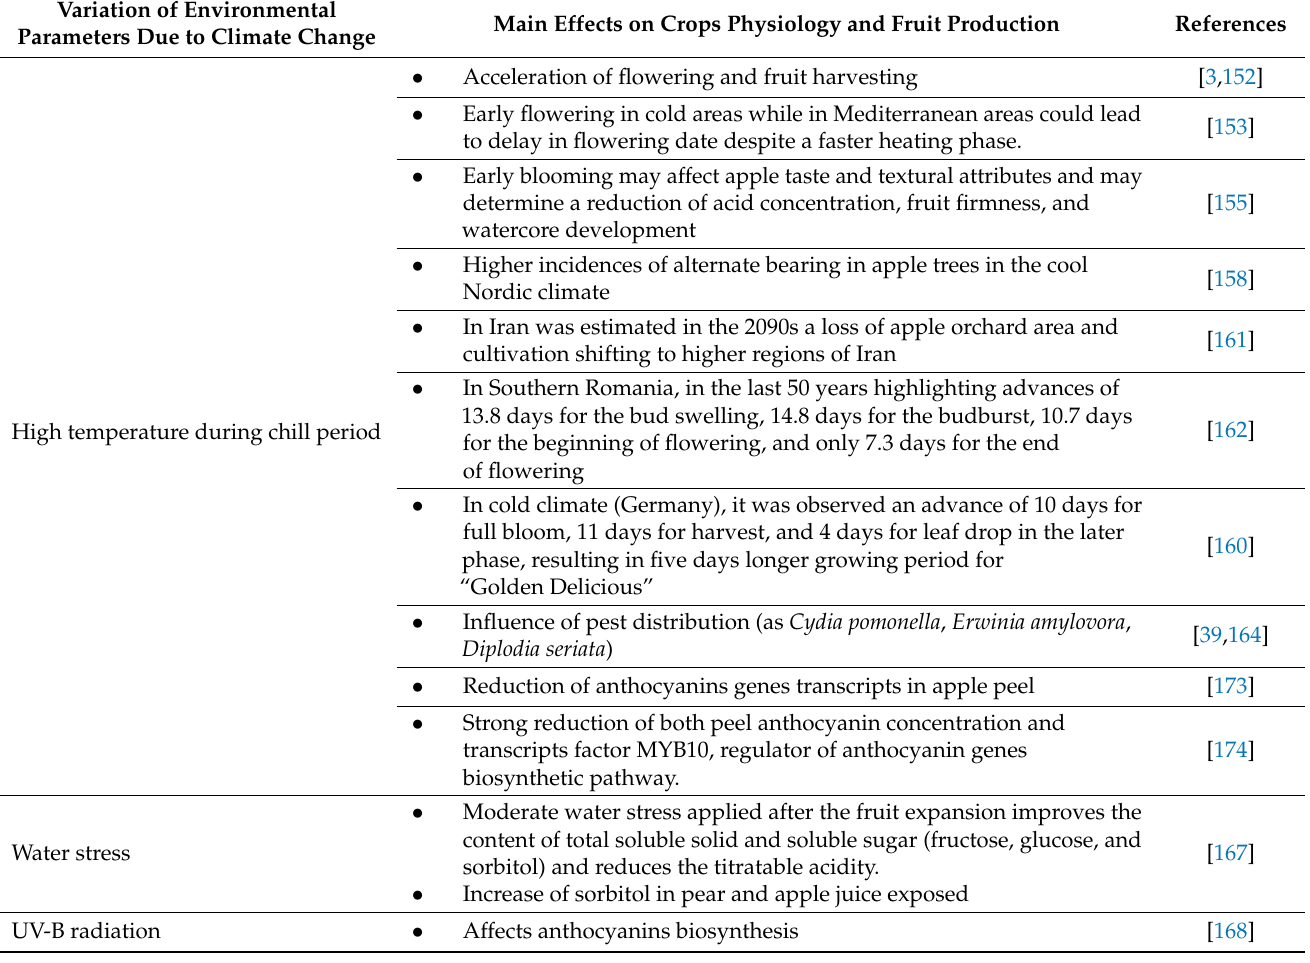
Table 12. Summary of principal effects of environmental conditions variation on apple